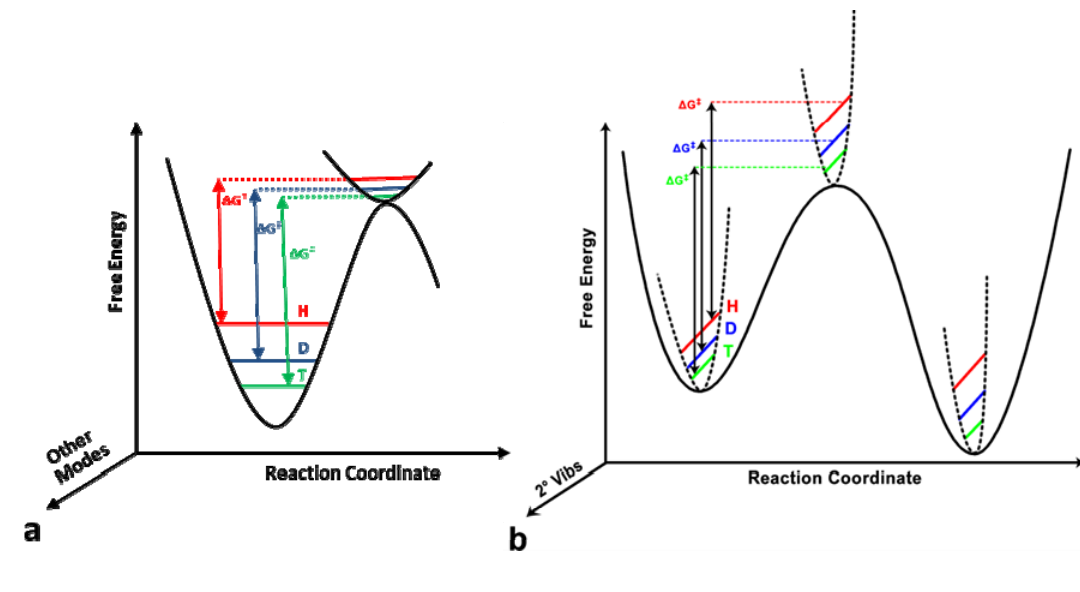
Figure 1. ( a ) Semi-classical model of 1° KIEs. KIEs arise from the difference in ZPE between the reactants at the GS and the TS. In this schematic, the reaction coordinate is